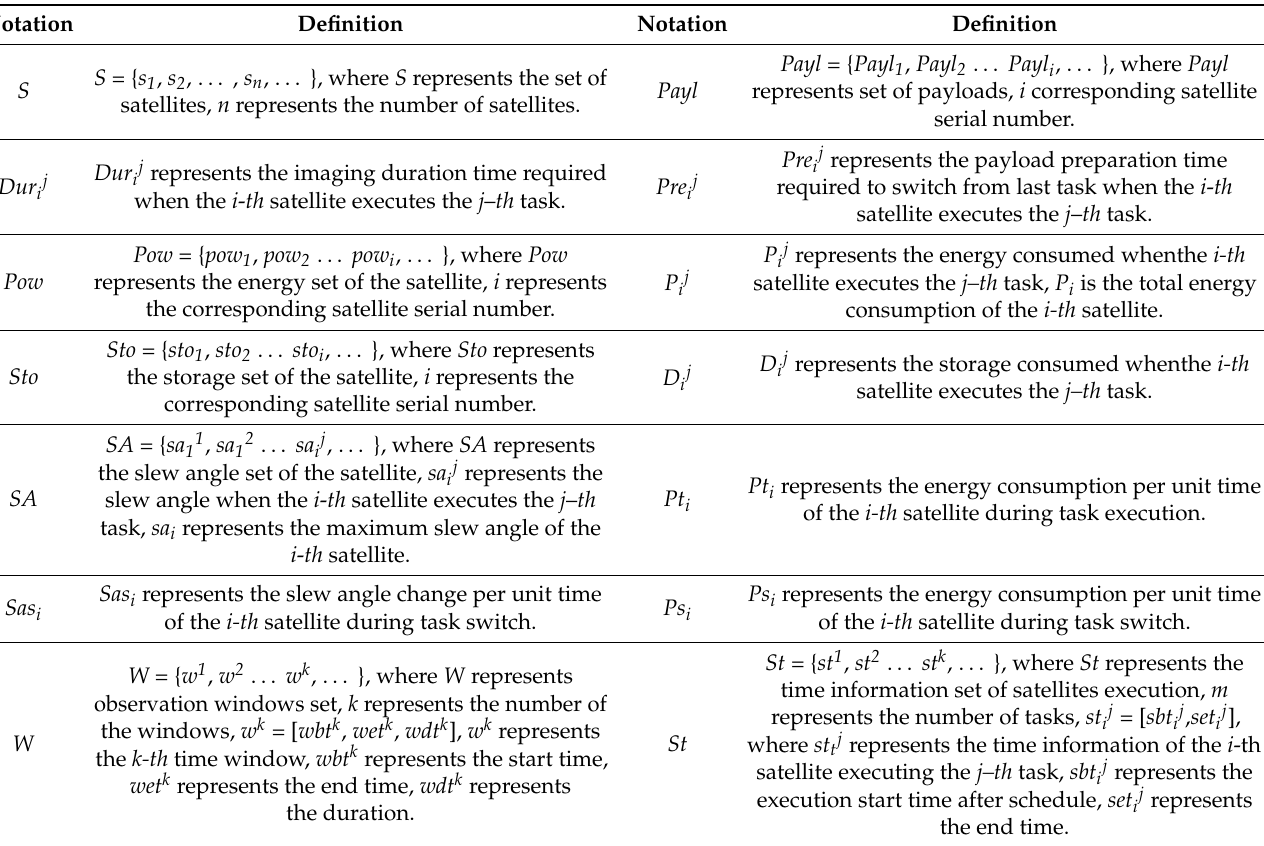
Table 1. Parameter and label